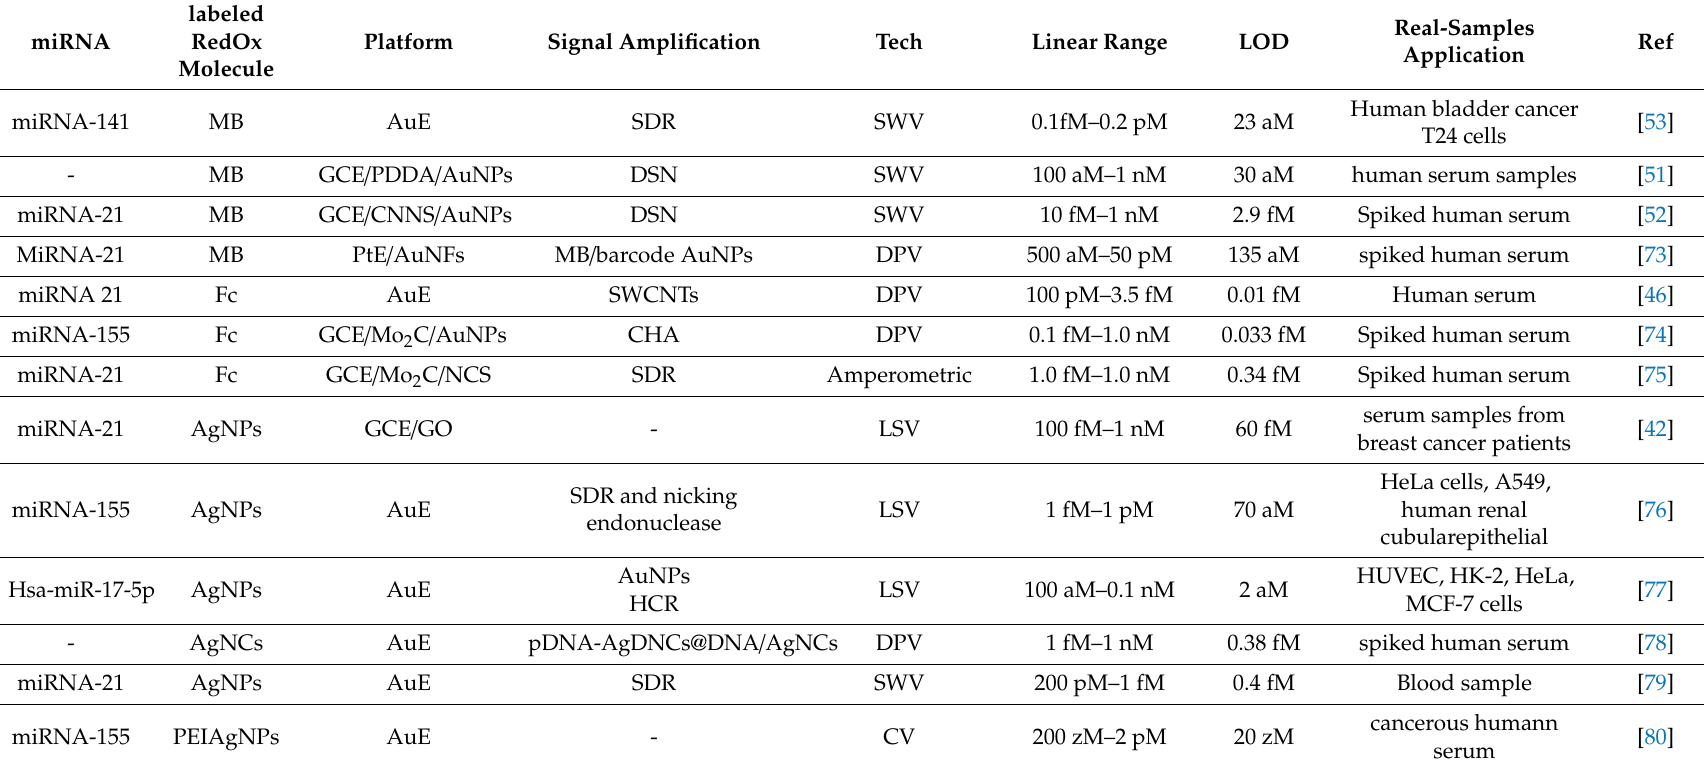
Table 2. Current sensitive electrochemical biosensors using electroactive species-labeled probe sequence miRNA detection.